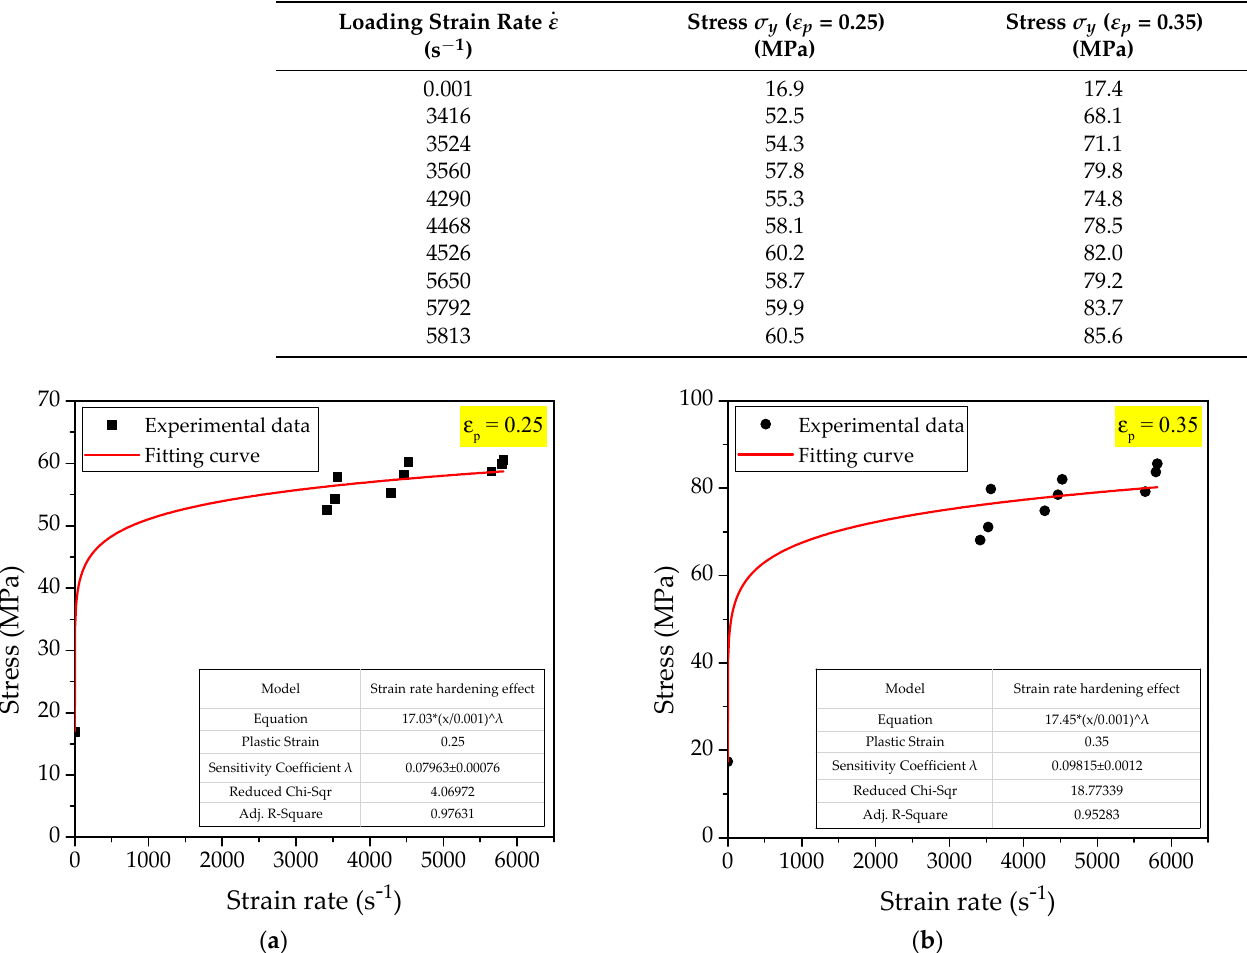
ε = 0.25; ( b ) ε = 0.35. p p